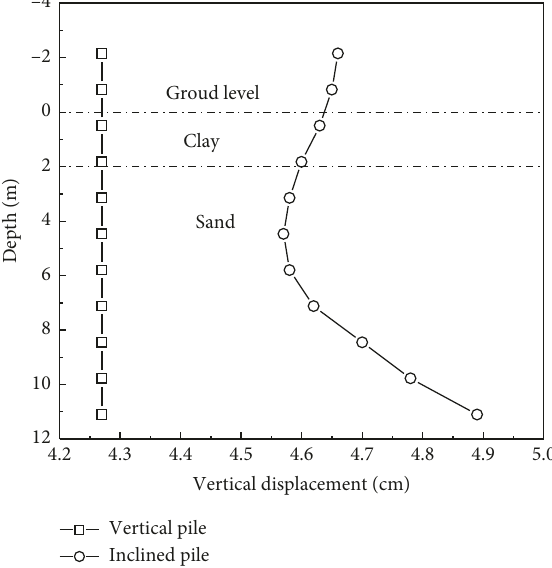
Figure 17: Vertical displacement of piles.